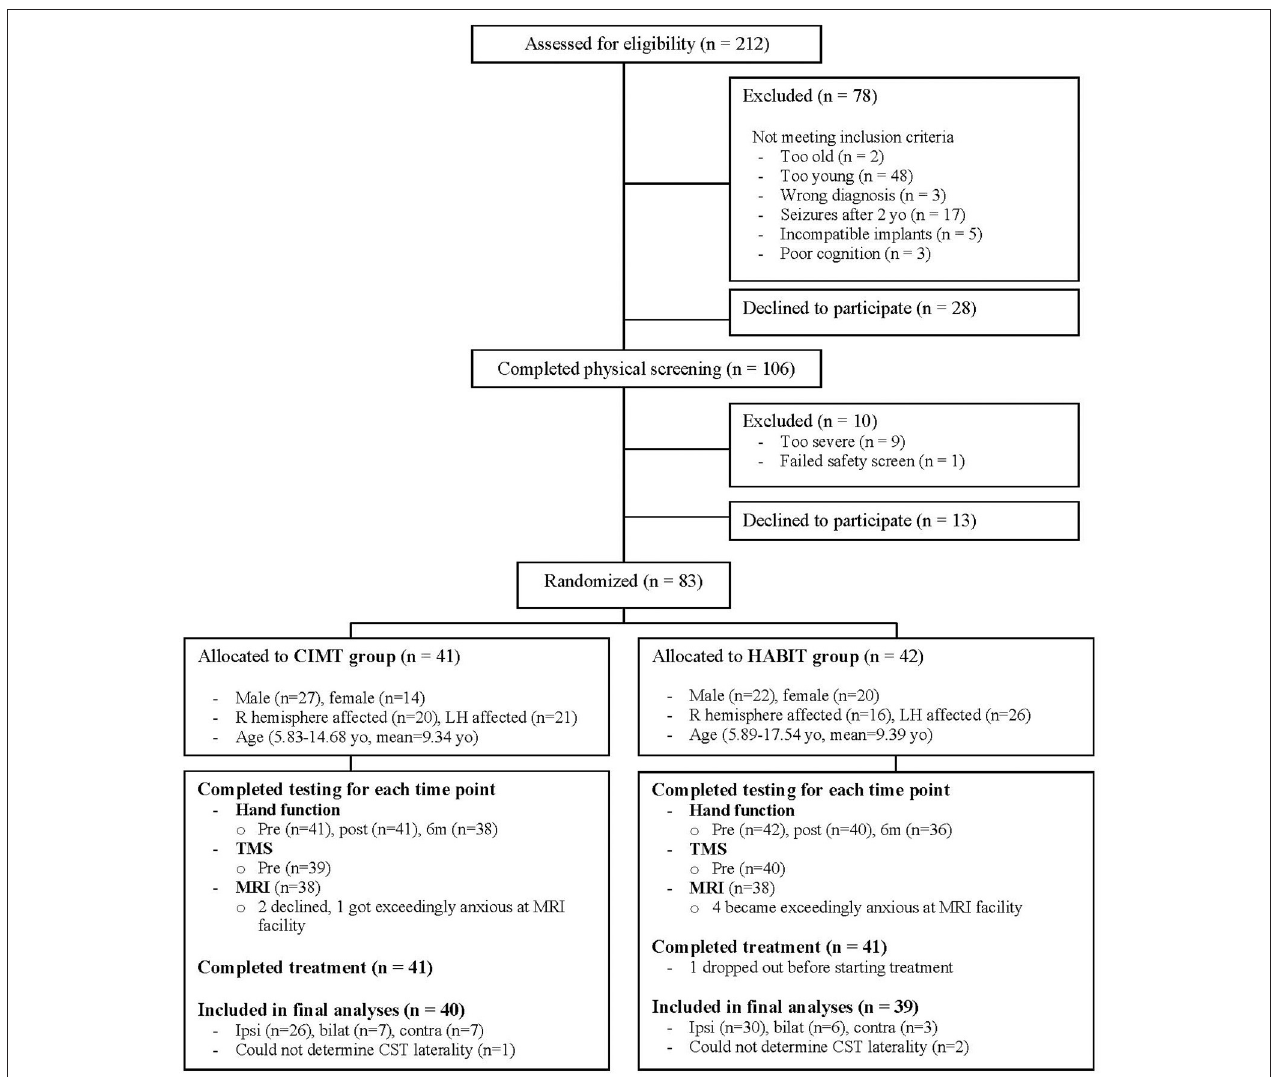
FIGURE 1 | CONSORT flow diagram showing progress through the stages of the study, including flow of participants, withdrawals, and inclusion in analyses. A total of 212 individuals were screened by phone or e-mail. Of these 78 children did not meet the study criteria and 28 declined participation. The remaining 106 children potentially met the study criteria and were invited to undergo physical screening. Ten children were excluded and 13 who qualified declined to participate. The remaining 83 children were stratified by age, sex, baseline hand function and CST connectivity pattern, and randomized to receive either CIMT or HABIT. One child in the HABIT group dropped out before starting treatment, and 41 children in each group completed the intended treatments. We were unable to complete TMS or DTI on 3 participants due to exceedingly high thresholds or safety concerns, so only data of the 79 participants with CST determination were included (39 for CIMT, 40 for